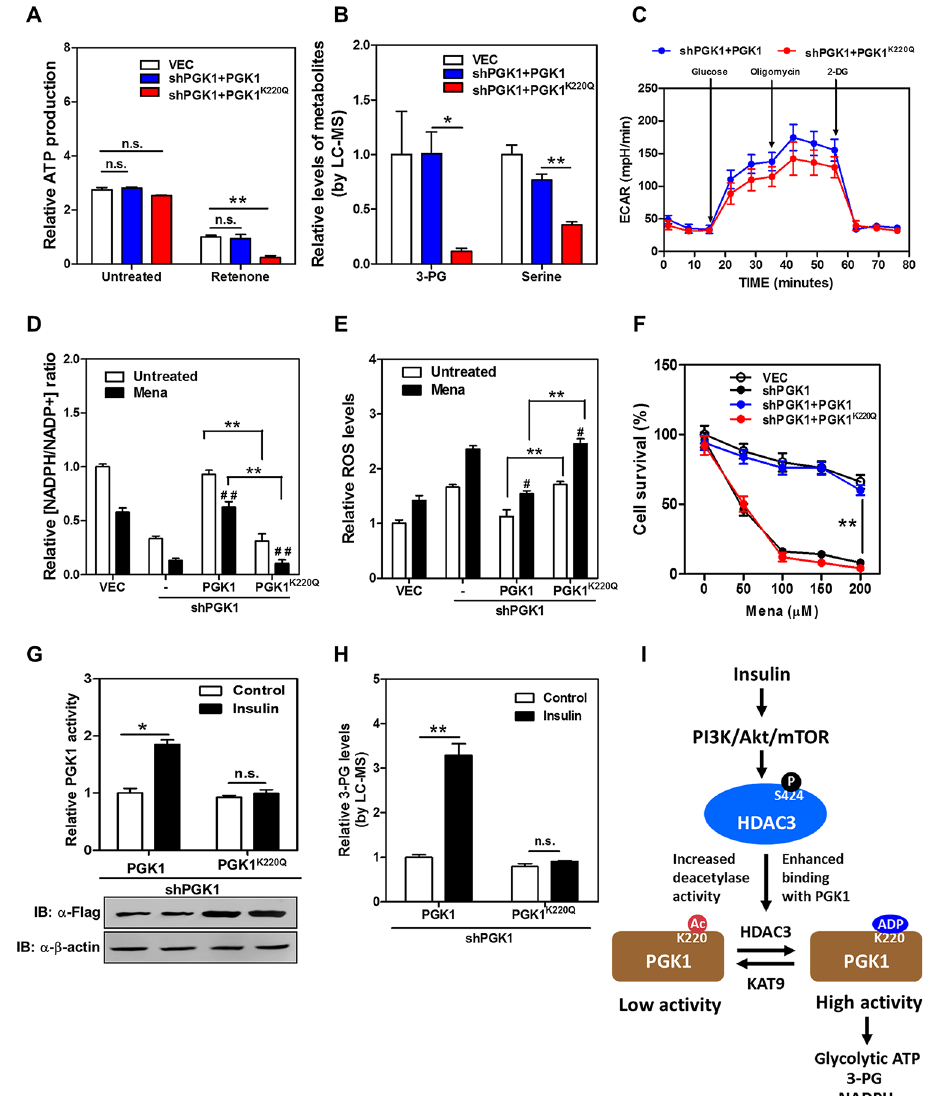
Fig 7. PGK1 K220 acetylation regulates glycolytic ATP production, glucose metabolism, and redox state of cells. ( A ) K220Q mutant PGK1 put-back cells display decreased glycolytic ATP production. Stable HEK293T cells were treated without or with Rotenone (100 nM for 6 hr), following measurement of cellular ATP production as described in S1 Text. The glycolytic ATP production in rescued cells expressing the empty vector (VEC, white column), wild-type PGK1 (blue column), and K220Q mutant PGK1 (red column) was compared. ( B ) K220Q mutant PGK1 put-back cells display decreased levels of 3-PG and serine. Stable HEK293T cells were rinsed with 1 ml ice-cold PBS for less than 1 min and quenched by using 80% (v/v) pre- cold (-80°C) methanol, following the standard LC-MS method to determine intracellular levels of 3-PG and serine as described in S1 Text. ( C ) K220Q mutant PGK1 put-back cells exhibit impaired glycolytic function. ECAR assay was performed in stable HEK293T cells using a Seahorse Bioscience XFe 96 analyzer system as described in S1 Text. The glycolytic function of rescued cells expressing wild-type PGK1 (blue circle) and K220Q mutant PGK1 (red circle) was compared. ( D ) K220Q mutant PGK1 put-back cells exhibit reduced NADPH/NADP + ratio. Stable HEK293T cells were treated without or with menadione (50 μ M for 30 min), and the ratio of NADPH/NADP + was determined by enzymatic analysis as described in S1 Text. ( E ) K220Q mutant PGK1 put-back cells exhibit higher ROS production. Stable HEK293T cells were treated without or with menadione (50 μ M for 30 min), and ROS accumulation was determined by using a fluorescent dye as described in S1 Text. ( F ) K220Q mutant PGK1 put-back cells show higher susceptibility to ROS-induced cell death. Stable HEK293T cells were treated with menadione at the indicated concentrations for 3 hr. The viability of cells without or with PGK1 knockdown (white or black circle), and cells with PGK1 knockdown and